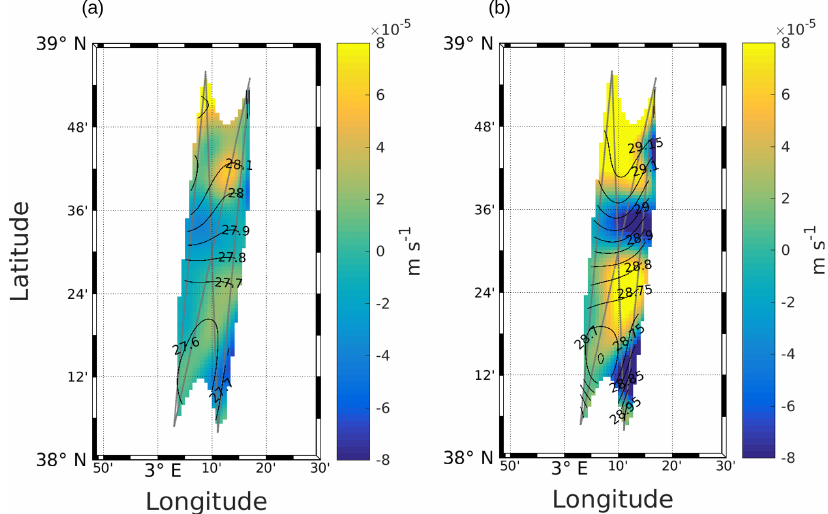
Figure 3. Maps of vertical velocities at (a) 25m and (b) 85m. Black lines represent the σ contours. The data have been selected where the error on the objective mapping of σ is ≤ 0 .